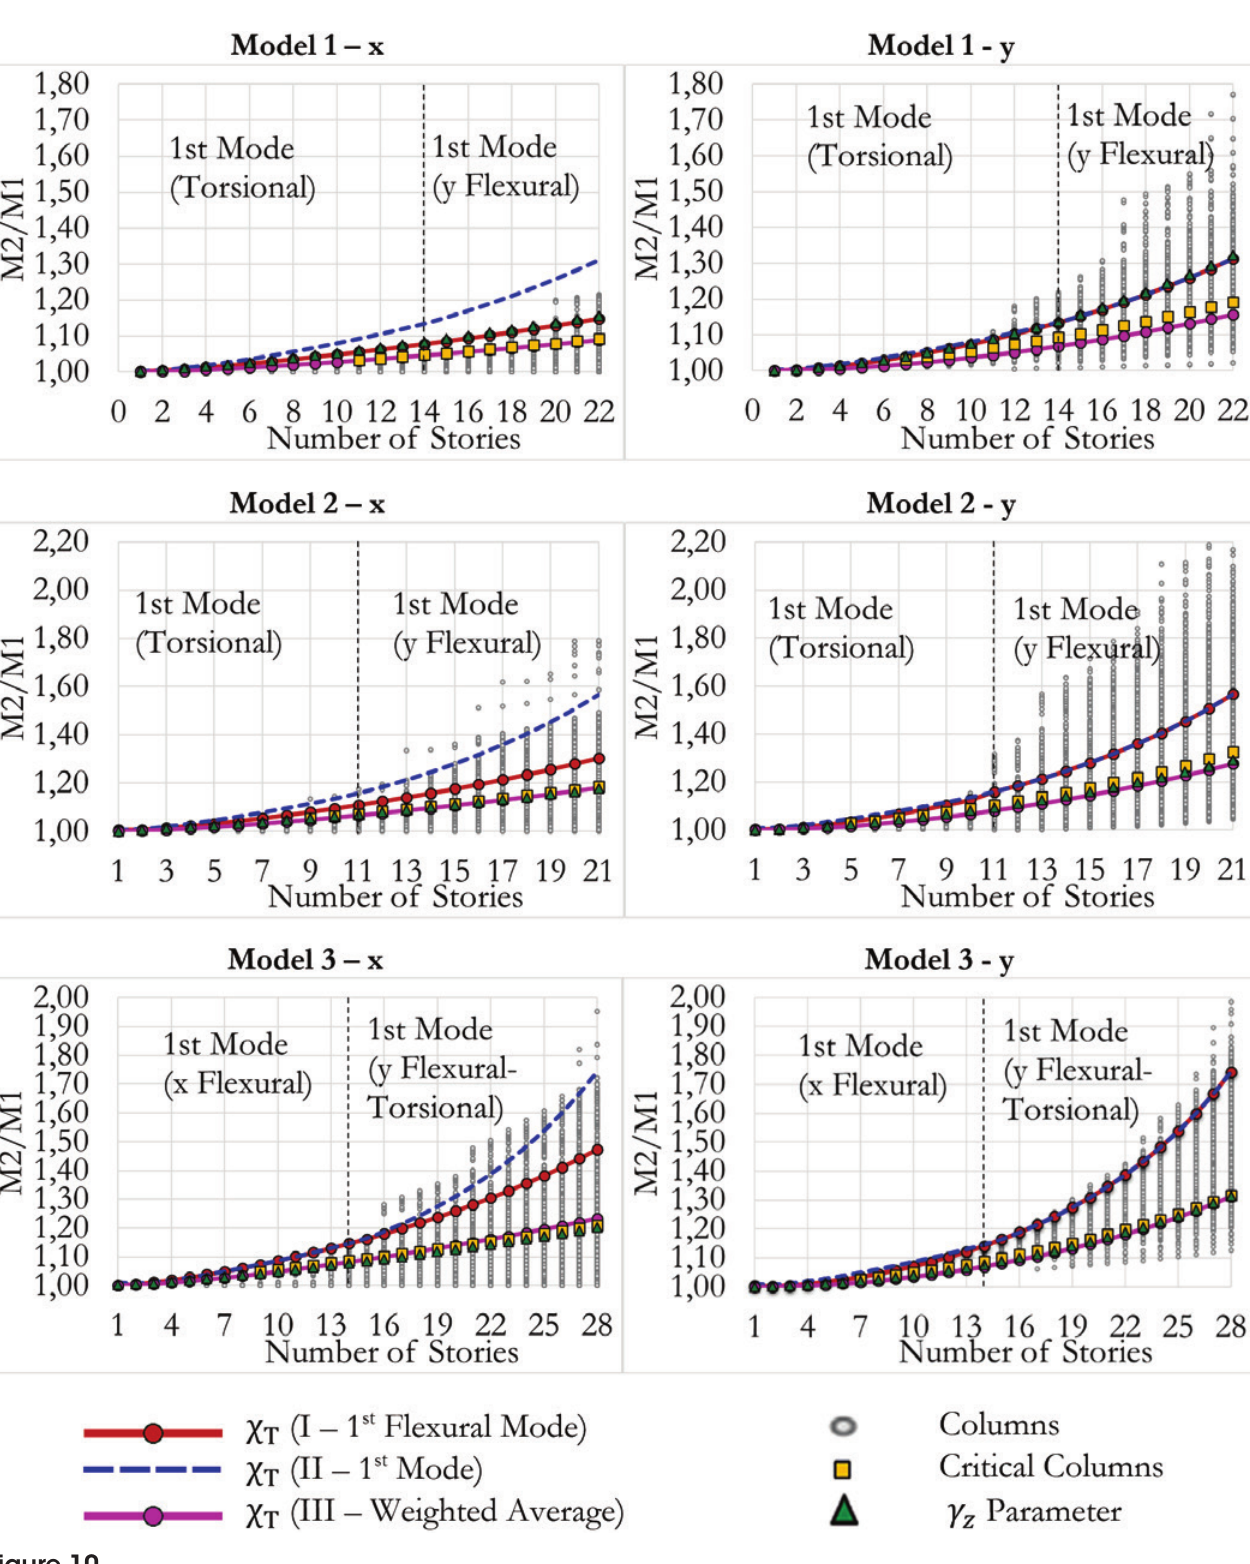
/M in function of the natural period of vibration in the assessed direction – 2 1